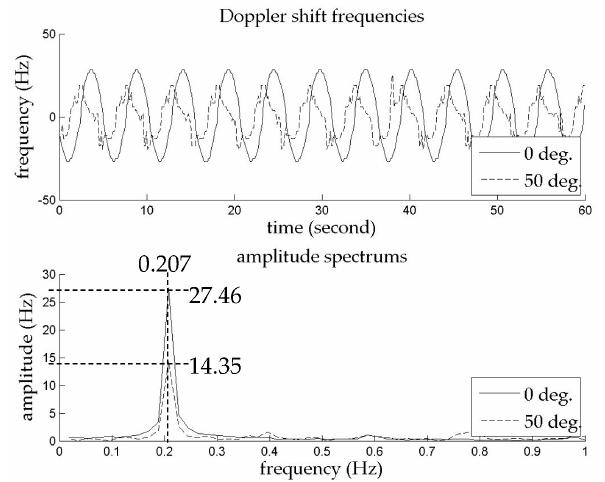
Figure 24. Two extracted Doppler shift frequencies and amplitude spectra. The angles to wave are 0 degrees and 50 degrees, and the coefficients: | cos ( 0 ) | = 1, | cos ( 50 o ) | = 0.643. The measurement results are shown in Table 8 and the bottom row gives the wave height obtained with the geometrical relationship of the two results, H 1 and H 2 . The measured period (4.81 s) and height (0.1552 m) are very close to the configured values of the generated wave, and errors are less than 3.8% and 3.5%, respectively. The measurement accuracy could be improved if more signals were sampled and more directions were